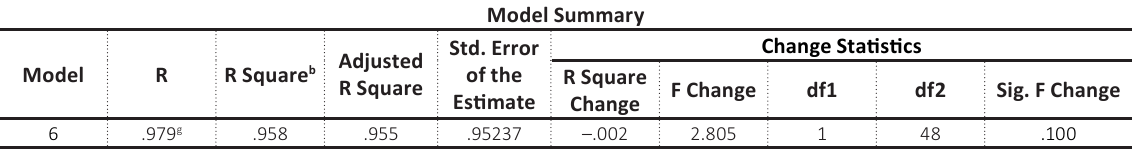
Table 4. Statistical evaluation table of the suitability of the linear regression model